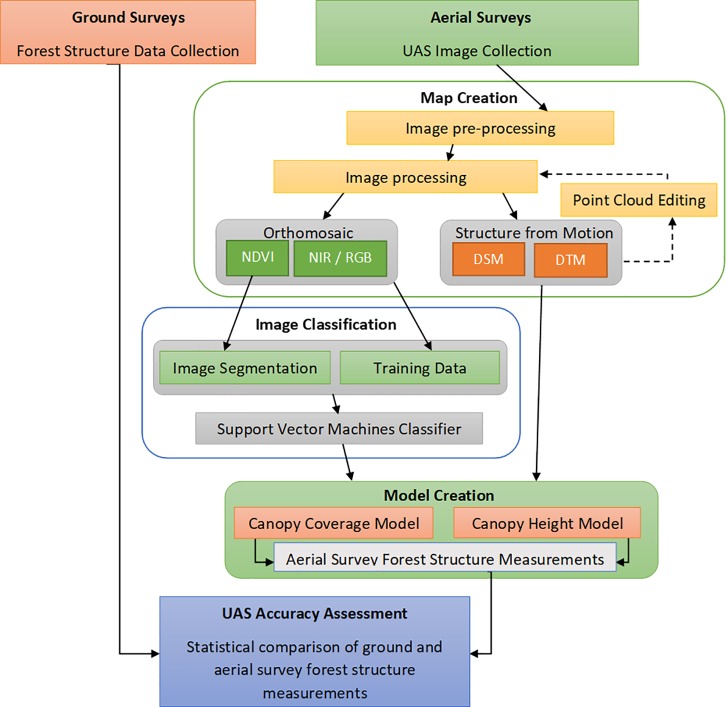
Model workflow of the accuracy assessment of ground data and aerial survey forest structure measurements.Data on forest structure collected from ground surveys was compared to forest structure data derived from canopy height (CHM) and canopy cover (CCM) models applied to support vector machine (SVM) classified UAS imagery maps.